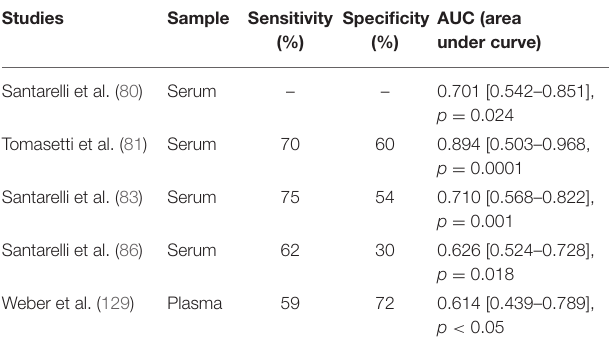
TABLE 2 | Ability of miR-126 to distinguish healthy subjects from malignant mesothelioma patients.